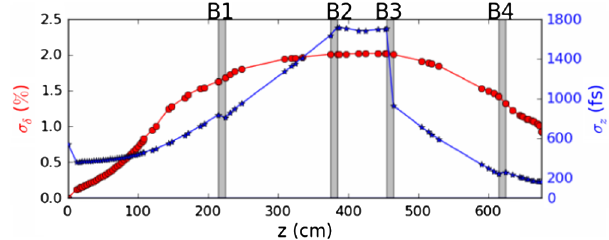
FIG. 8. Evolution of rms energy spread (the red circles) and rms longitudinal bunch length (the blue stars) along the linac bunch compressor of case 1 in Table II. The four gray bars show the four dipole magnets of the chicane compressor. The rms energy spread is calculated by 100% particles. The rms longitudinal bunch length is calculated for 90% of particles, with 10% longitudinal tail cutoff (as explained in the footnote of Table I).